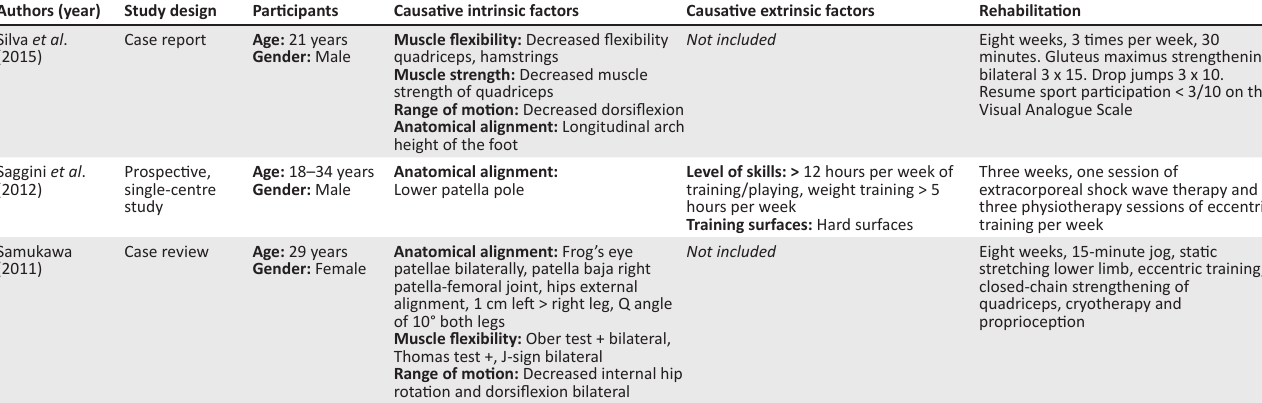
TABLE 4: Causative factors and